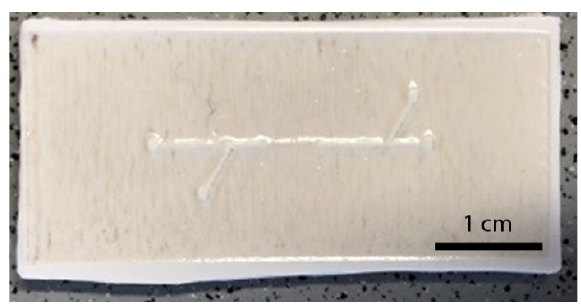
Figure 16. ABS casting mold fabricated with laser exposure.